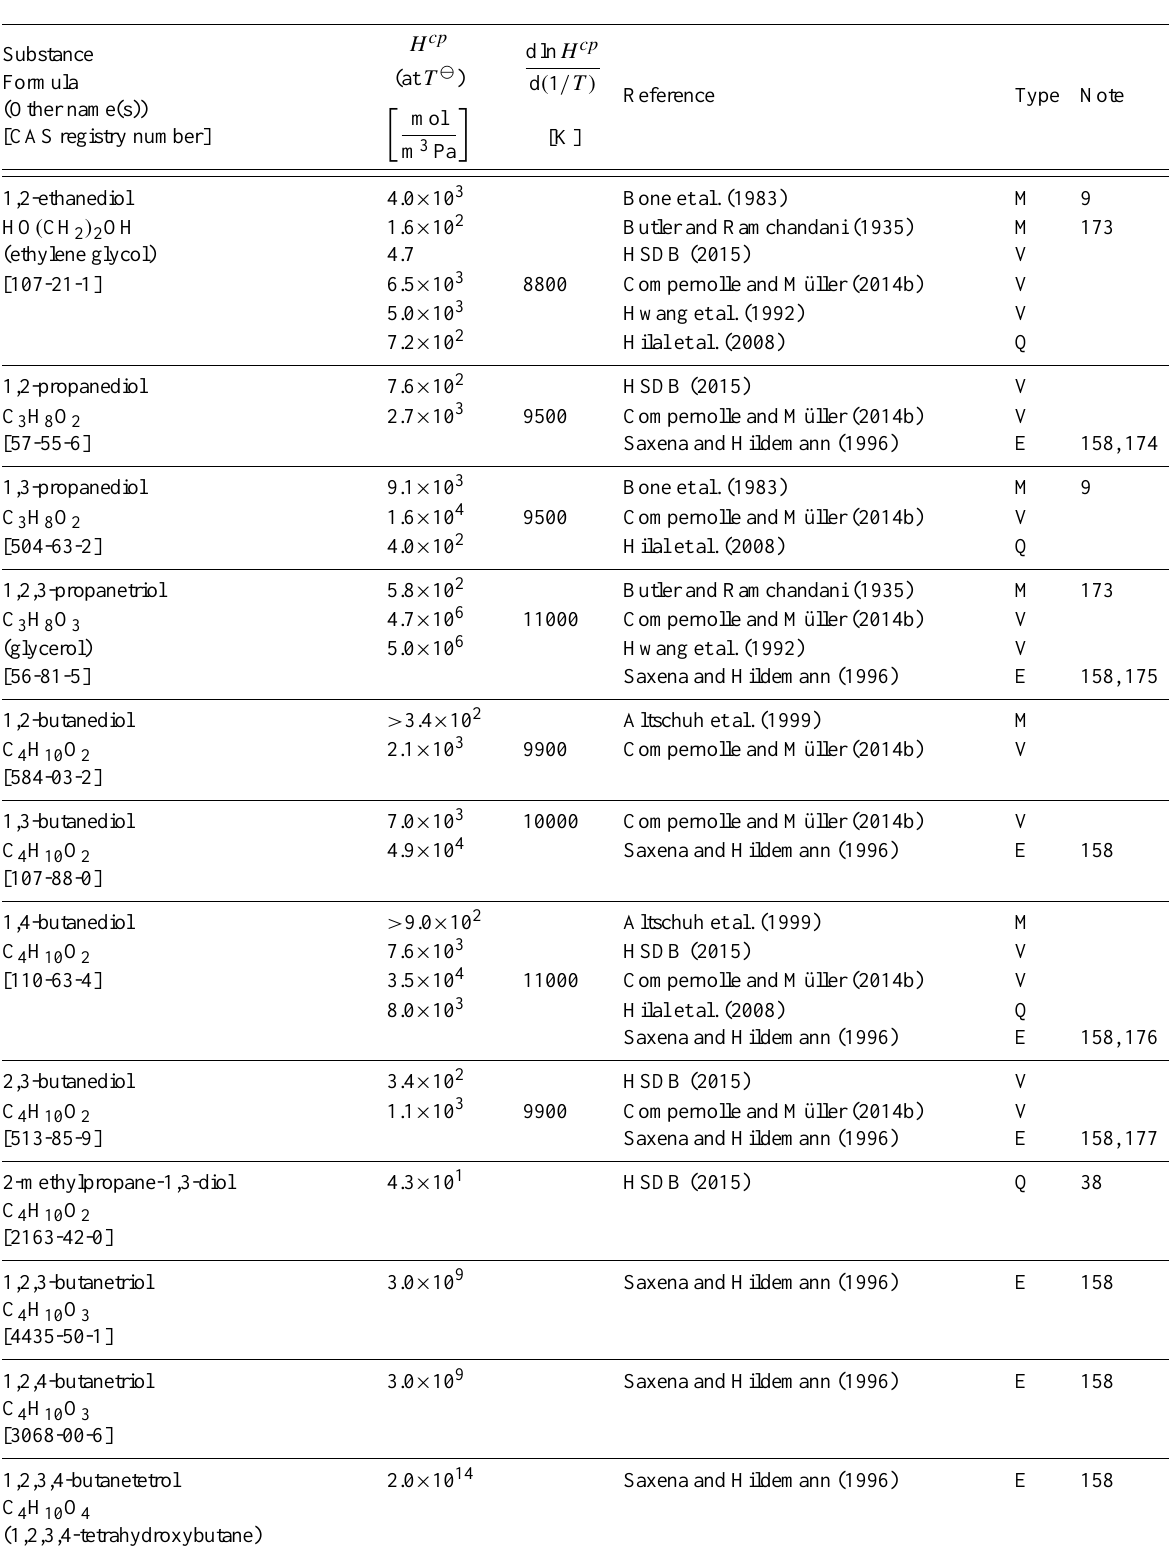
Table 6: Henry’s law constants for water as solvent